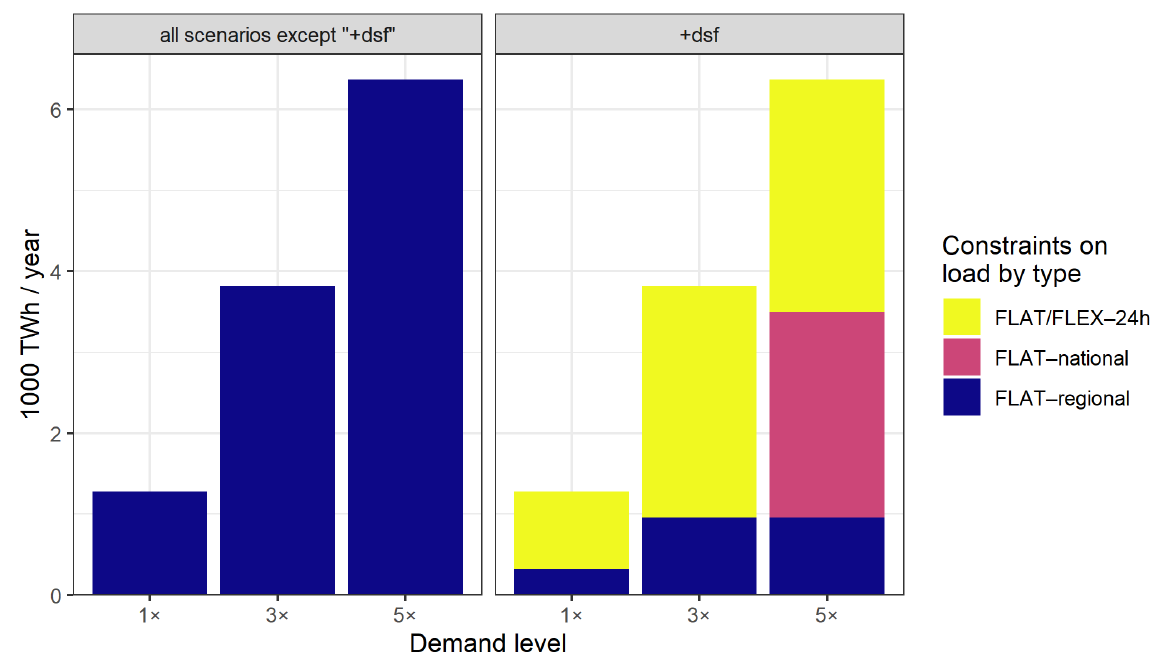
Figure 4. Demand structure and constraints by scenarios before optimisation. Notes: FLAT, fixed and constant in time (load) for every hour and region through the year; FLEX-24h, responsive demand shiftable within 24 h load on all 365 calendar days, with total daily load constant and equal across all scenarios; FLAT-regional, lower constraint ensuring minimum 25% of flat load in total annual consumption for every region in the 1 × and 3 × scenarios and 15% of total load in 5 × scenarios; FLAT-national, nationwide constraint in 5 × scenarios, ensures additional flat load in total national consumption, with location of load optimised by the model; FLAT/FLEX-24h, optimisation area between flat and flexible loads.